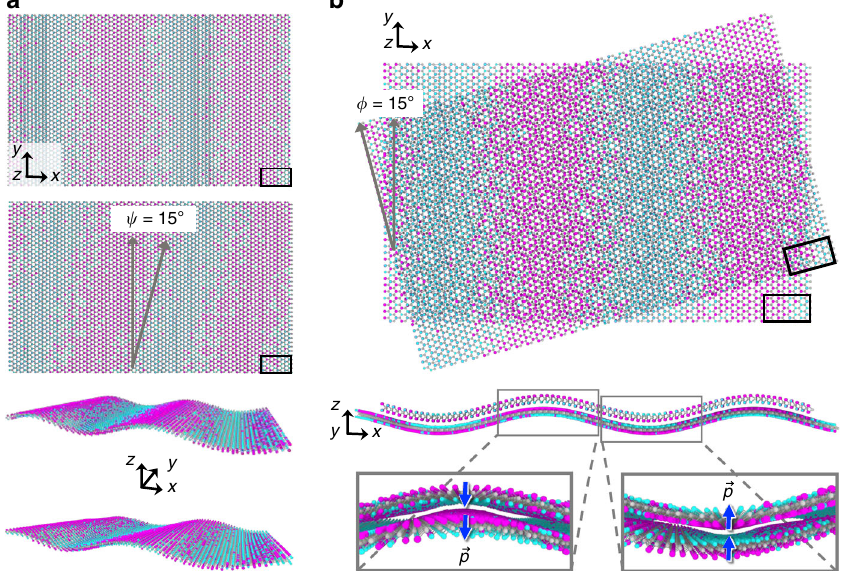
Fig. 5 Programming the twist between TMD alloy monolayers with Janus patterns. a Atomic representations of two monolayers compositionally patterned along different crystallographic directions separated by an angle ψ . b When stacked, the twist angle ϕ is stabilized at ψ by the preference to align the programmed out-of-plane deformations and electric dipole patterns of the two